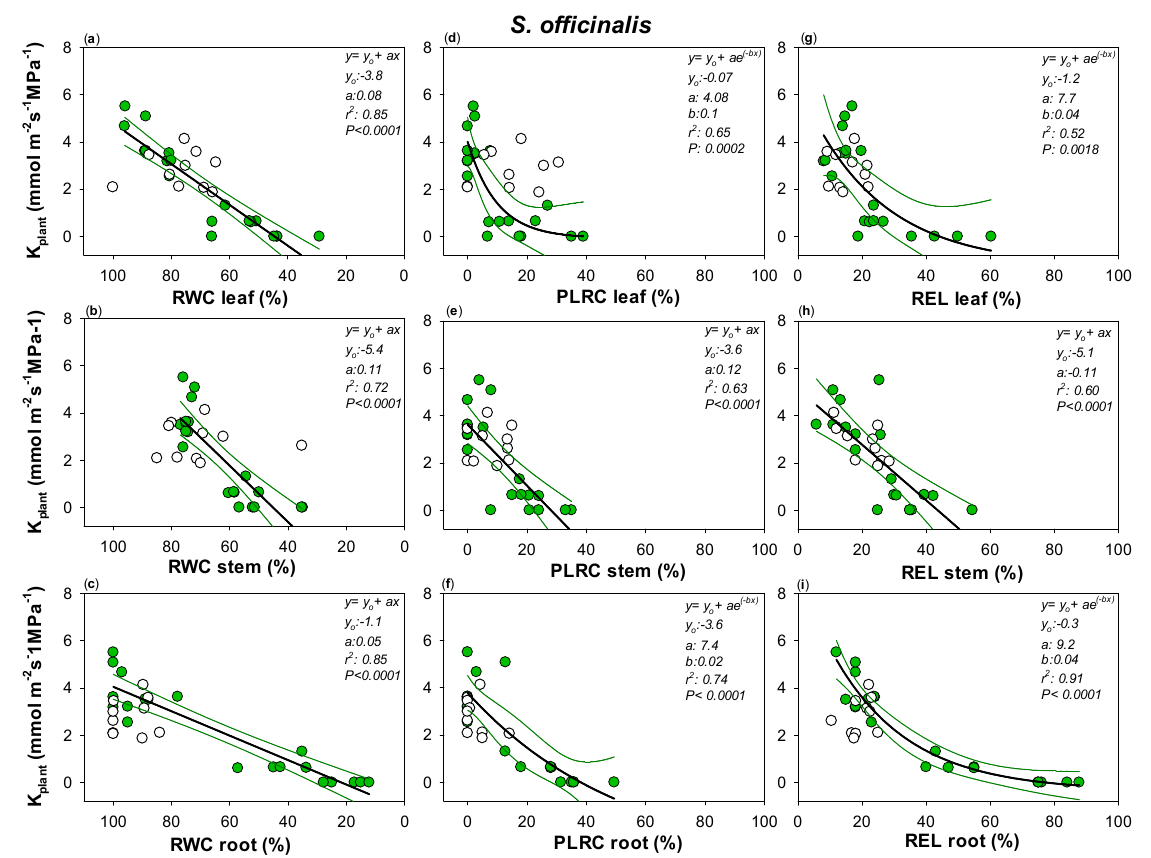
Figure 5. Relationships between plant hydraulic conductance (K plant ) and ( a ) leaf, ( b ) stem and ( c ) root relative water content (RWC leaf, RWC stem and RWC root, respectively), ( d ) leaf, ( e ) stem and ( f ) root percentage loss of leaf rehydration capacity (PLRC leaf, PLRC stem, PLRC root) and ( g ) leaf, ( h ) stem and ( i ) root relative electrolyte leakage (REL leaf, REL stem and REL root) as measured in S. officinalis . Best fitted regression curves are designed by dark line. Confidence intervals are designed by green lines. White symbols indicate data recorded in re-irrigated samples and not included in the regression. Regression equation, coefficient values, correlation coefficients (r 2 ) and p values are also reported.